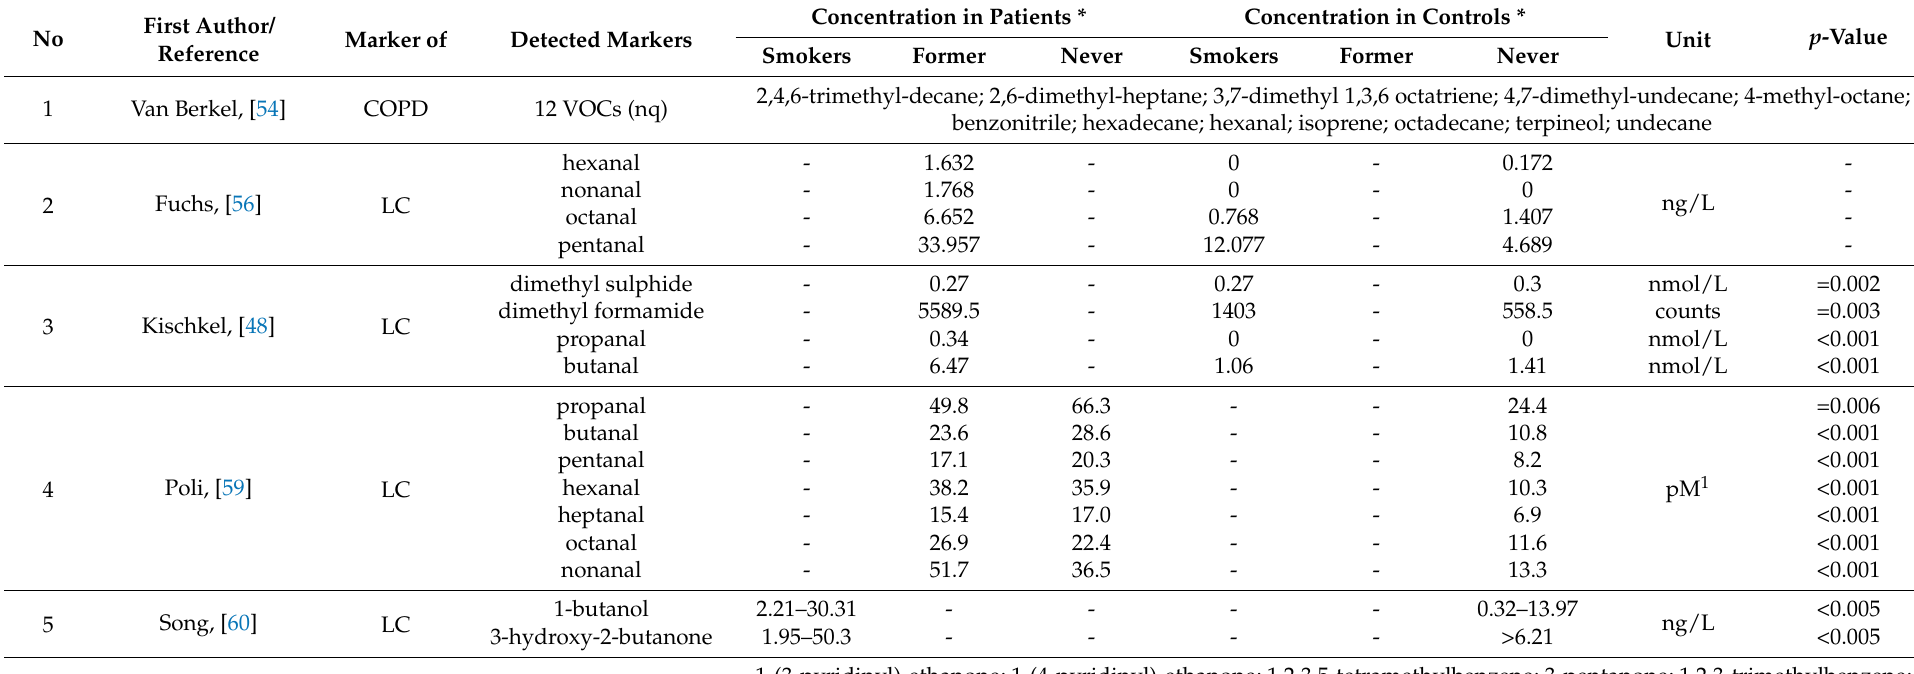
Table 3. Markers associated with the three reviewed respiratory